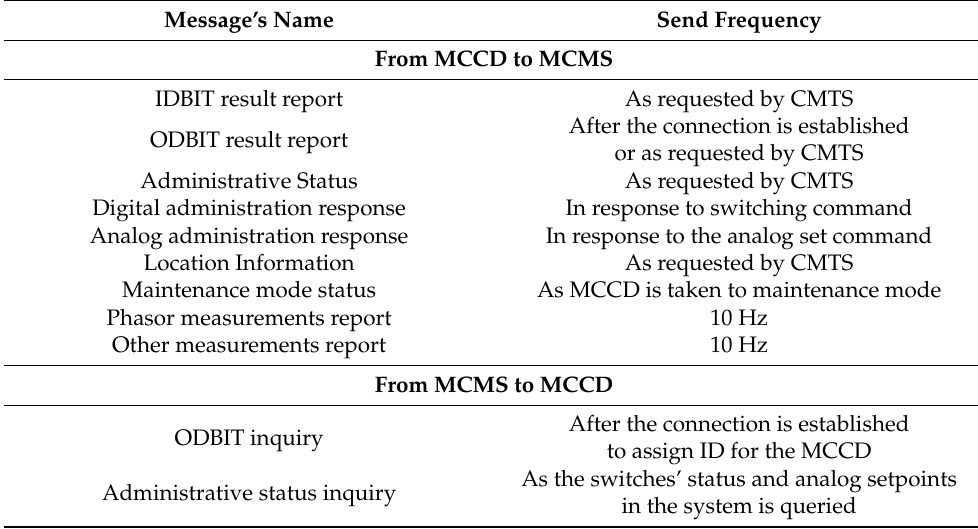
Table A2. Description of messages transmitted between CMTS and